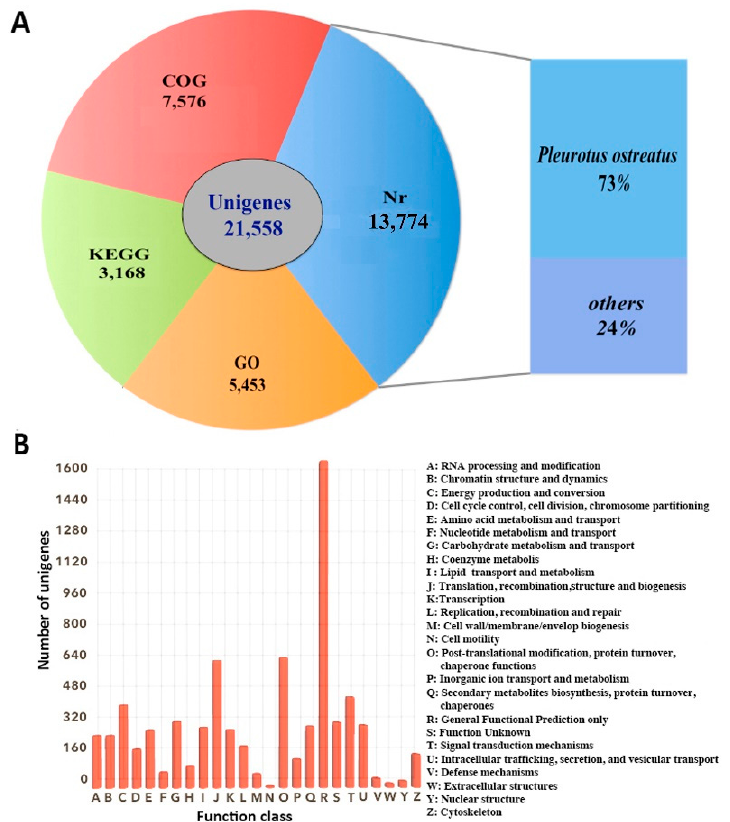
Figure 2. Unigene annotation. ( A ) Number of unigenes blasted to Non-Redundant (NR), Clusters of Orthologous Groups (COG), Gene Ontology (GO) and Kyoto Encyclopedia of Genes and Genomes (KEGG) databases ( e < 0.00001); ( B ) COG classification. A total of 7576 unigenes were assigned to 25 classifications. The capital letters on the x-axis indicate the COG categories as listed on the right of the histogram.